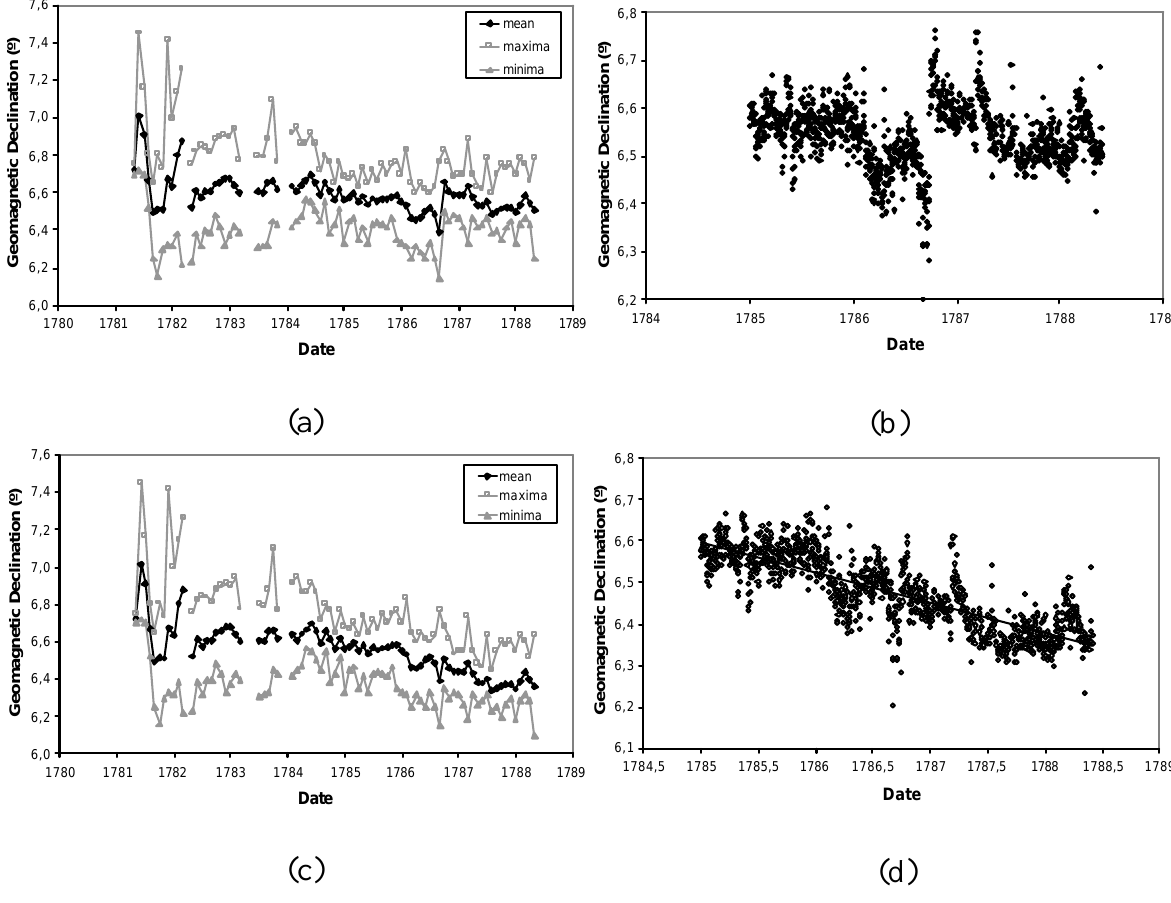
Fig. 1. Original measurements of geomagnetic declination performed by Sanches Dorta at the (a) monthly and (b) daily scales and after the correction at (c) monthly and (d) daily scales. Figure 1. Original measurements of geomagnetic declination performed by Sanches Dorta at Figure 1. Original measurements of geomagnetic declination performed by Sanches Dorta at Figure 1. Original measurements of geomagnetic declination performed by Sanches Dorta at Figure 1. Original measurements of geomagnetic declination performed by Sanches Dorta at the (a) monthly and (b) daily scales and after the correction at (c) monthly and (d) daily the (a) monthly and (b) daily scales and after the correction at (c) monthly and (d) daily the (a) monthly and (b) daily scales and after the correction at (c) monthly and (d) daily the (a) monthly and (b) daily scales and after the correction at (c) monthly and (d) daily scales. scales. scales. scales.